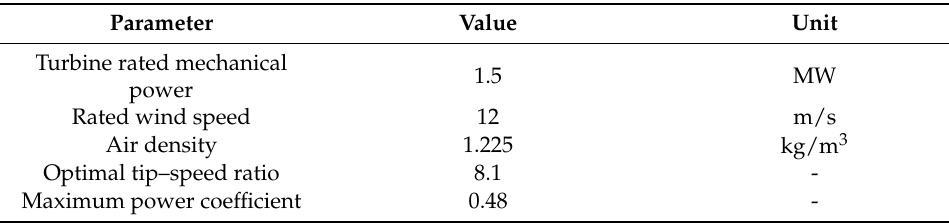
Table A1. Parameter of 1.5 MW WT.